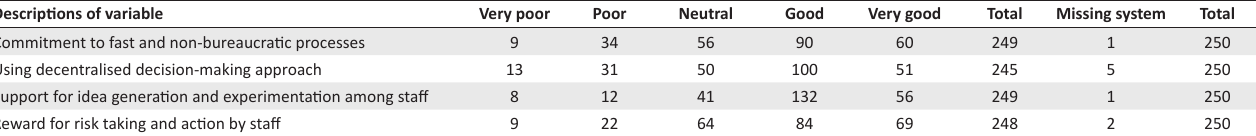
TABLE 3: Using only